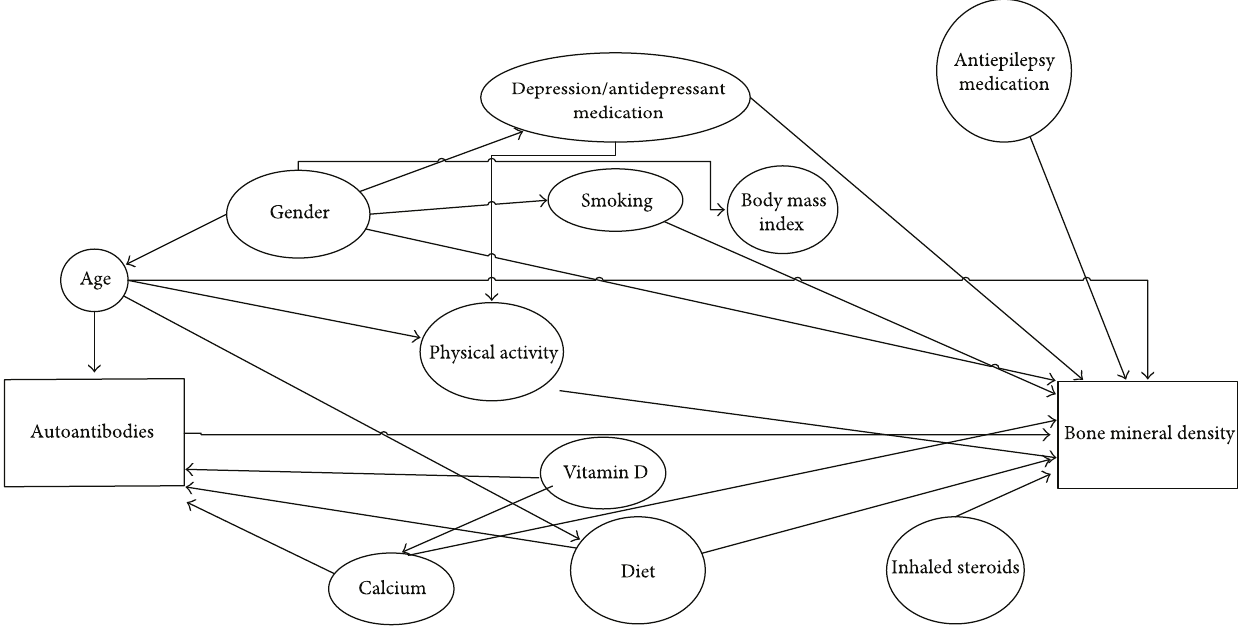
Figure 1: Directed acyclic graphs: determining confounding variables.